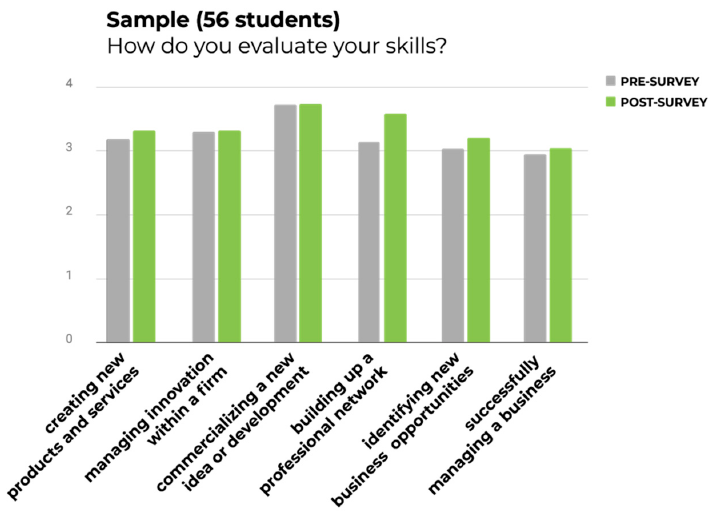
Figure 3. The overall perception of the students’ entrepreneurial skills in the pre- and post-course